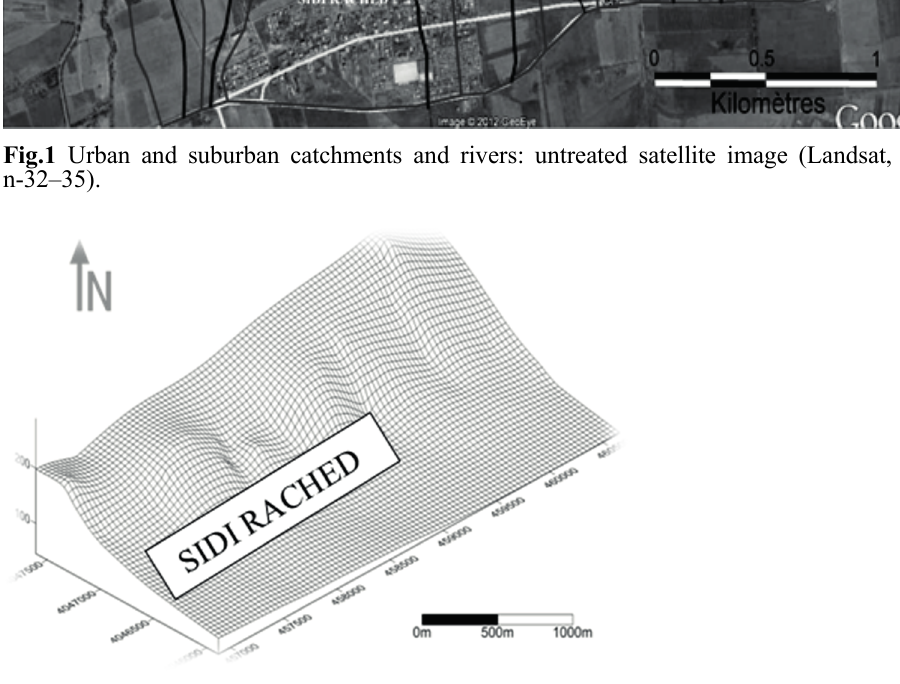
Fig. 2 Sight 3D (MNT) of the study area. Table 1 Physiographical and hydro-morphometric characteristics of the basins. Basin